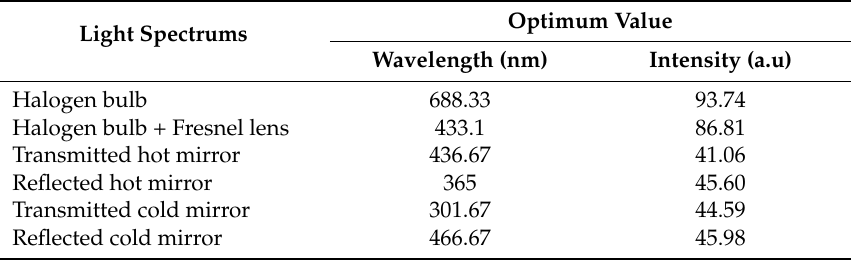
Table 2. Halogen light spectrums of different